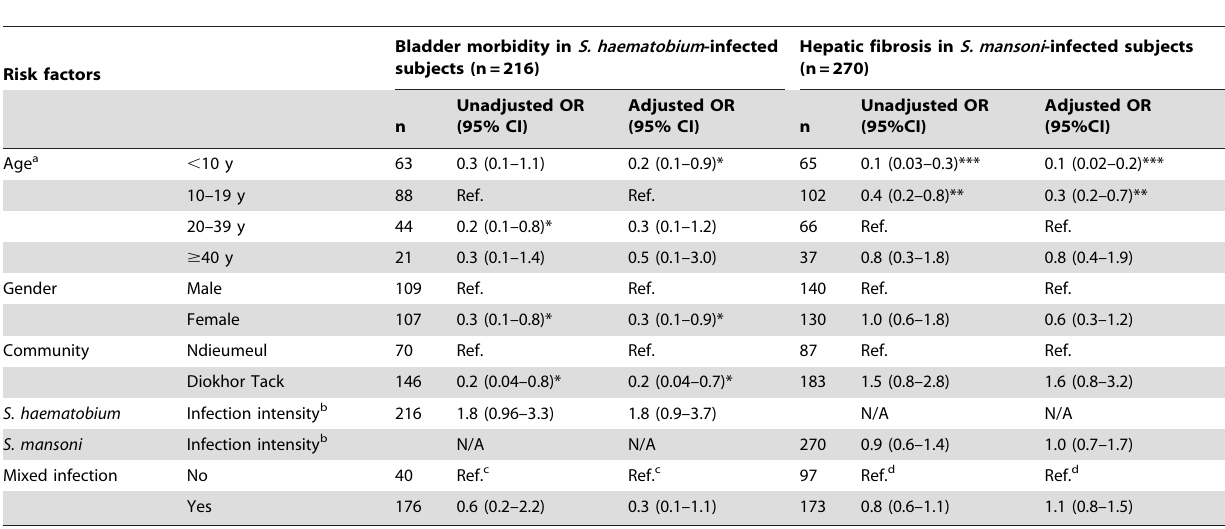
Table 5. The effect of mixed Schistosoma infection on bladder morbidity and on hepatic fibrosis.